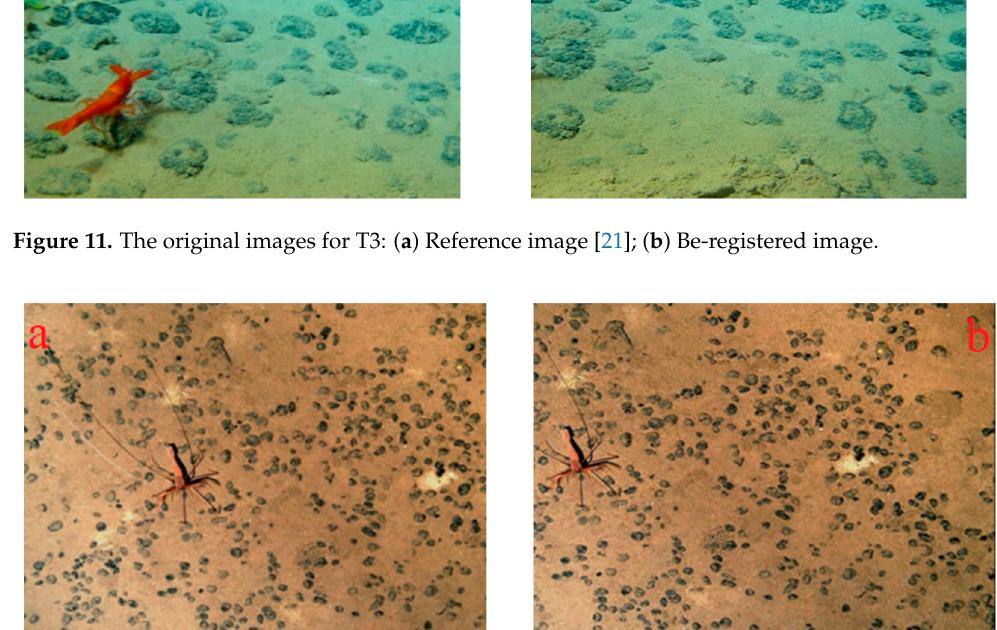
Figure 12. The original images for T4: ( a ) Reference image [43]; ( b ) Be-registered image.